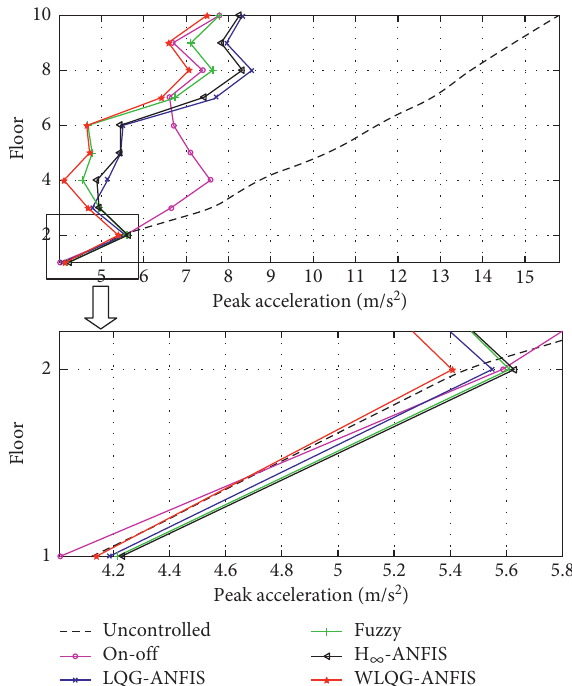
Figure 14: Comparison of peak accelerations of all the floors among different control